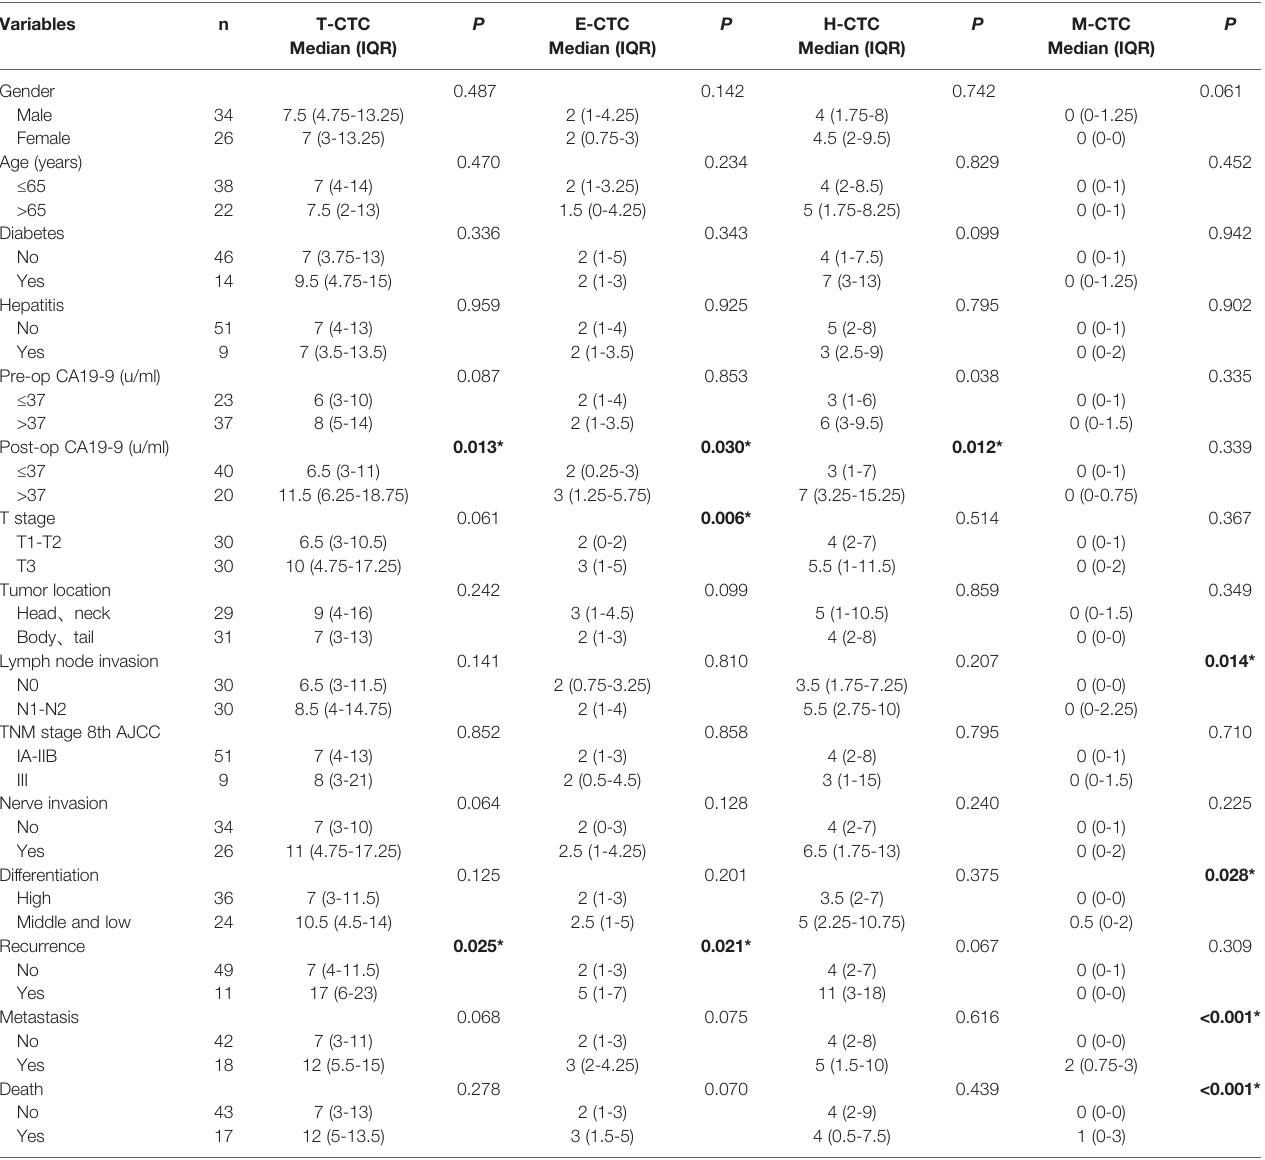
TABLE 1 | Correlation between PoV CTC phenotype count and baseline characteristics.